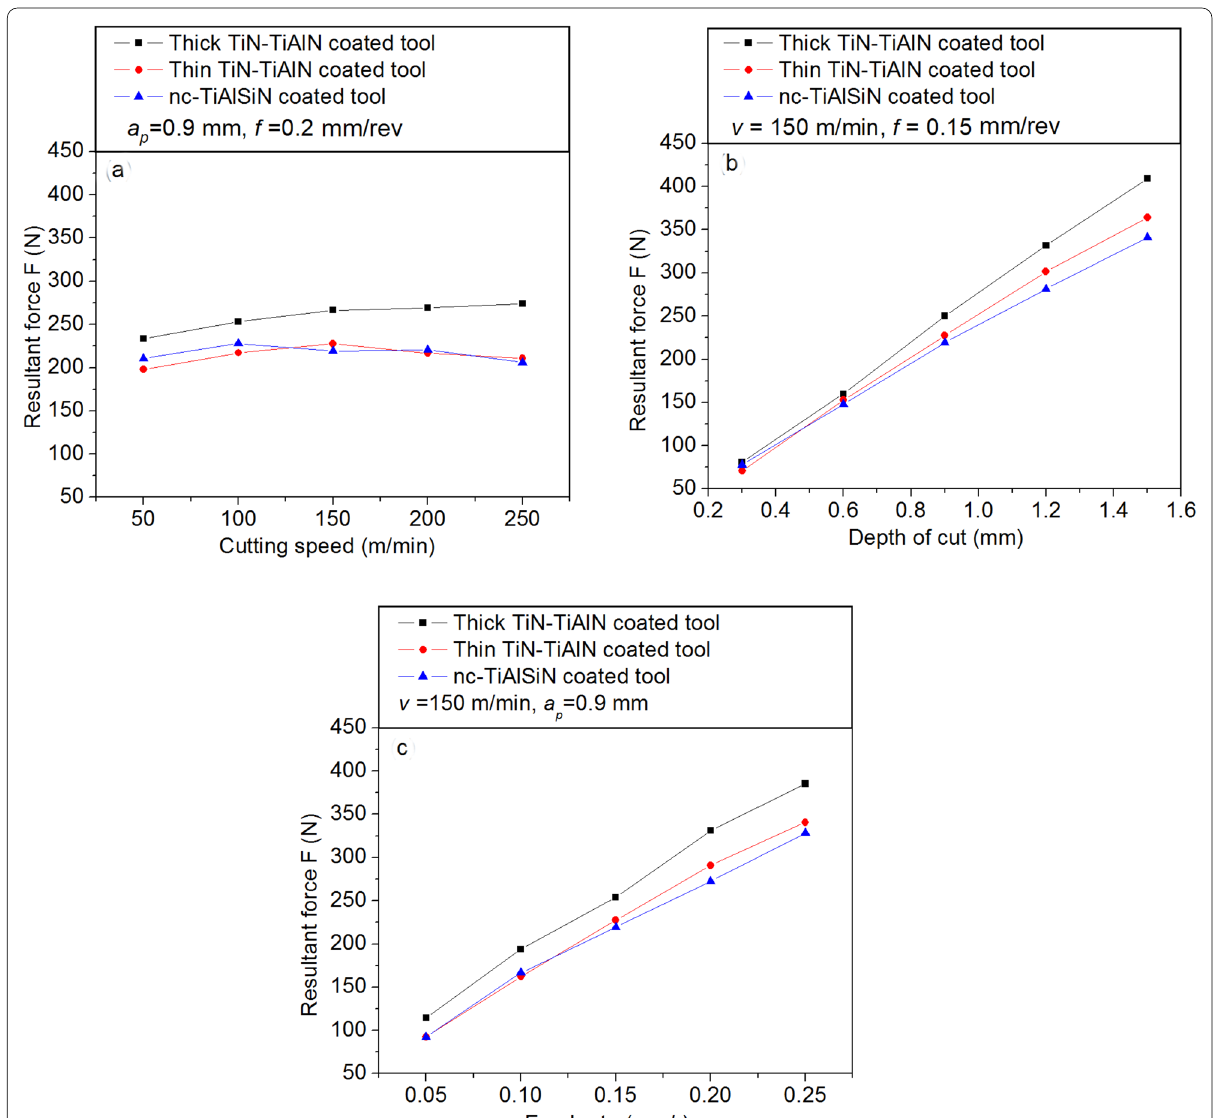
Figure 3 Resultant cutting forces of the three coated tools under various cutting conditions in dry turning of MCI: a a p b v 150 m/min, f 0.15 mm/rev; and c v = =